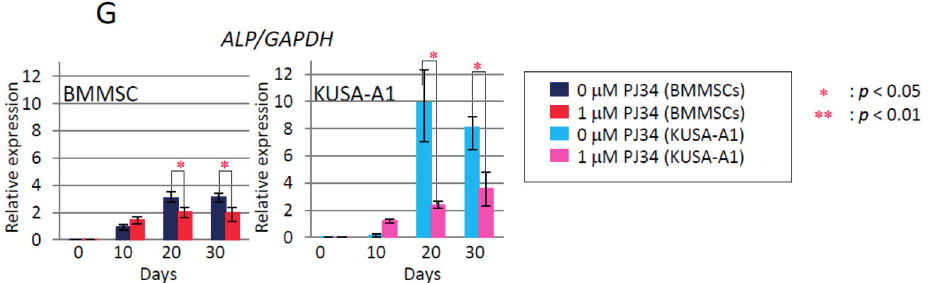
Figure 7. Effects of PJ34 on mRNA expression levels of osteogenic differentiation markers in BMMSCs and KUSA-A1 cells. Cells were treated with 0 and 1 µM PJ34 for 30 days, with medium changed every three days. The mRNA levels analyzed every 10 days were Runx2 ( A ); Osterix ( Osx ) ( B ); Bone Morphogenetic Protein-2 ( BMP-2 ) ( C ); Osteocalcin ( OCN ) ( D ); bone sialoprotein ( BSP ) ( E ); Osteopontin ( OPN ) ( F ); and alkaline phosphatase ( ALP ) ( G ). Values are expressed as mean ± SEM. * p < 0.05, ** p < 0.01.